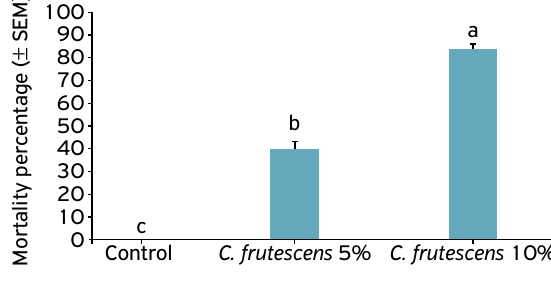
SEM: standard error of the Figure 7. Percentage mortality (mean ± SEM) of adult of Achatina fulica two days after application of treatments (control and alcoholic extract of Capsicum frutescens ) at 5 and 10% in lettuce ( Lactuca sativa ) on the field.